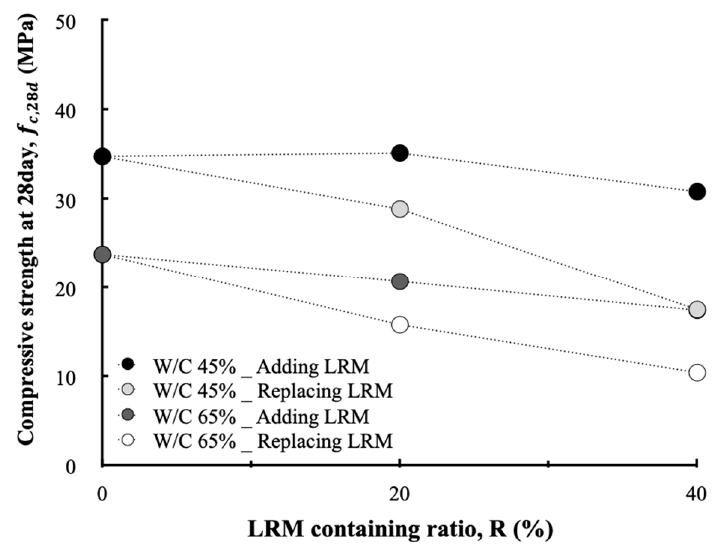
Figure 11. Compressive strength at 28 d according to the LRM containing ratio.